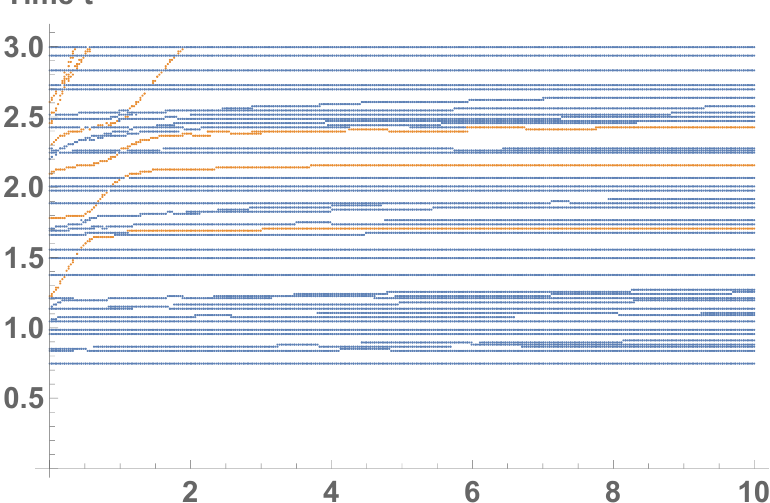
Figure 11 . The times of all conjugate points with the chaotic 4-body deformation δH 2 with N = 6 fermions. For ease of visibility, some of the easily distinguishable nonlocal conjugate points are highlighted in orange, while the blue lines correspond to µ -independent local conjugate points.